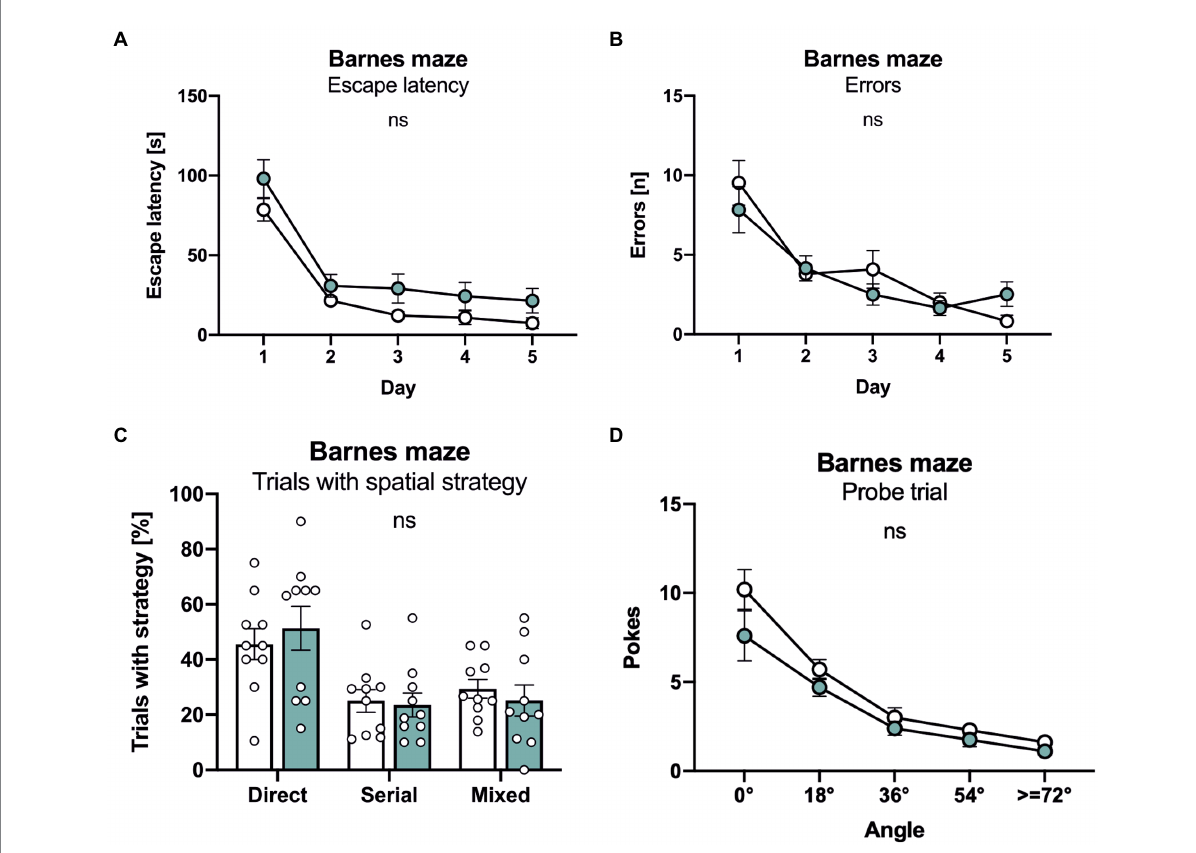
FIGURE 5 APLP1-KOs show no deficits in the Barnes maze. (A) : Barnes Maze (BM), throughout training, latency to escape the maze decreased similarly in APLP1-KO and control animals. [geno F (1, 18) = 4.271 ns; day F (2.347, 42.24) = 61.08, p < 0.0001; day × geno F (4, 72) = 0.2359 ns]. (B) : BM, APLP1-KO animals reduced their number of errors during training to the same extent as wildtype controls. [geno F (1, 18) = 0.1351 ns; day F (2.279, 41.03) = 29.47, p < 0.0001; day × geno F (4, 72) = 1.812 ns]. (C) : BM, trials of APLP1-KO mice with a direct spatial strategy was not significantly altered compared to wildtype controls. [strategy F (1.412, 25.42) = 7.964 ns; geno x strategy F (2, 36) = 0.3051 ns]. (D) : BM, during the probe trial, APLP1-KO animals performed as well as wildtype controls. [geno F (1, 18) = 3.113 ns; angle F (1.465, 26.37) = 54.39, p < 0.0001; angle × geno F (4, 72) = 1.129